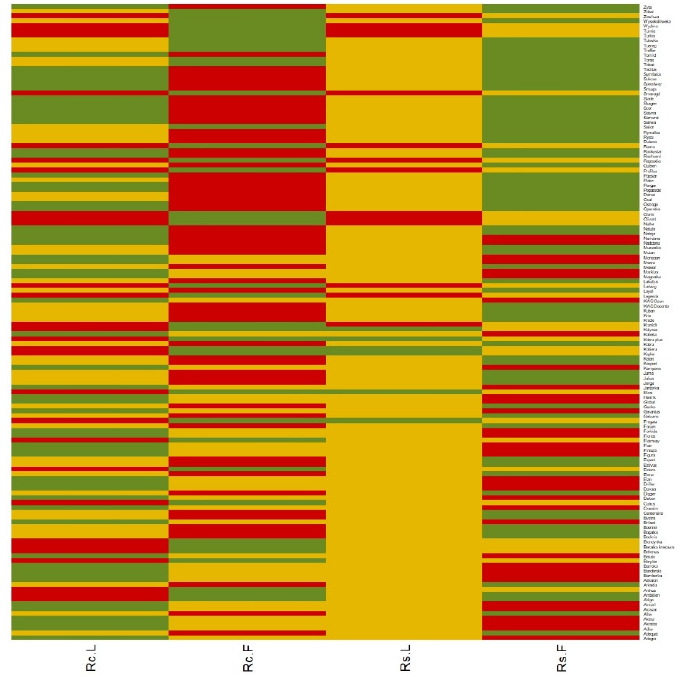
Figure 2. The heatmap of the infestation distribution of the tested plants in individual experimental variants, i.e., the type of pathogen and the type of experiment (laboratory, field). The colors successively correspond to the clusters to which the plants were assigned using the hierarchical K-means method: green—potentially resistant, yellow—moderate, red—susceptible/non-resistant. Rc.L— R. cerealis in the laboratory conditions, Rc.F— R. cerealis in the field conditions, Rs.L— R. solani in the laboratory conditions, Rs.F— R. solani in the field conditions.